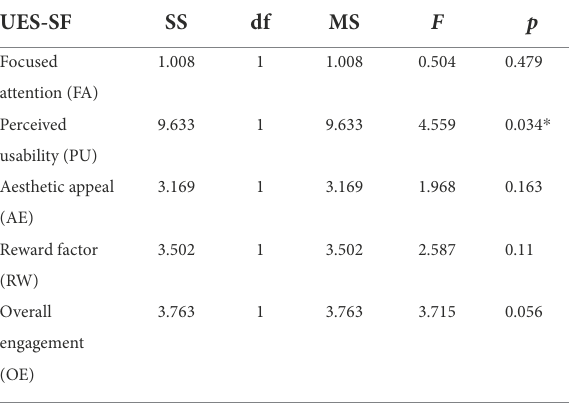
TABLE 7 Within-subjects effect test for different indicators under the NOEE and ESVD groups.